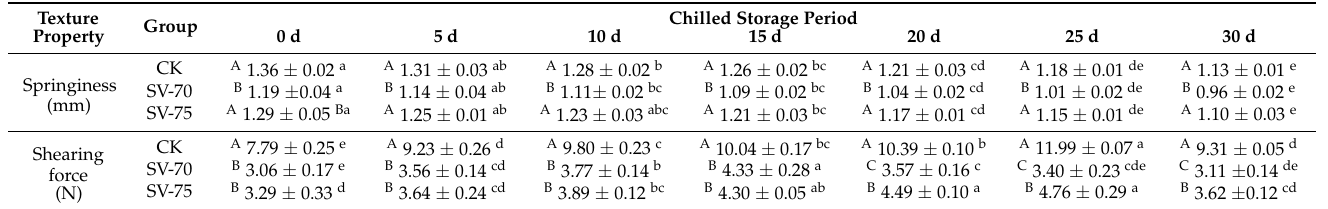
Table 1. Changes in springiness and shearing force of scallop muscle with different treatments during 30 d of chilling